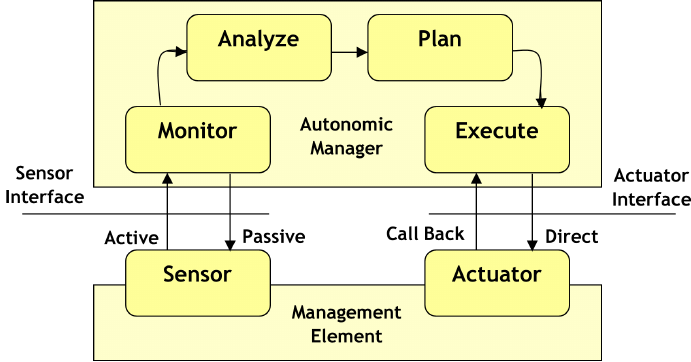
Figure 1. Sensor function in IoT enabled Medical